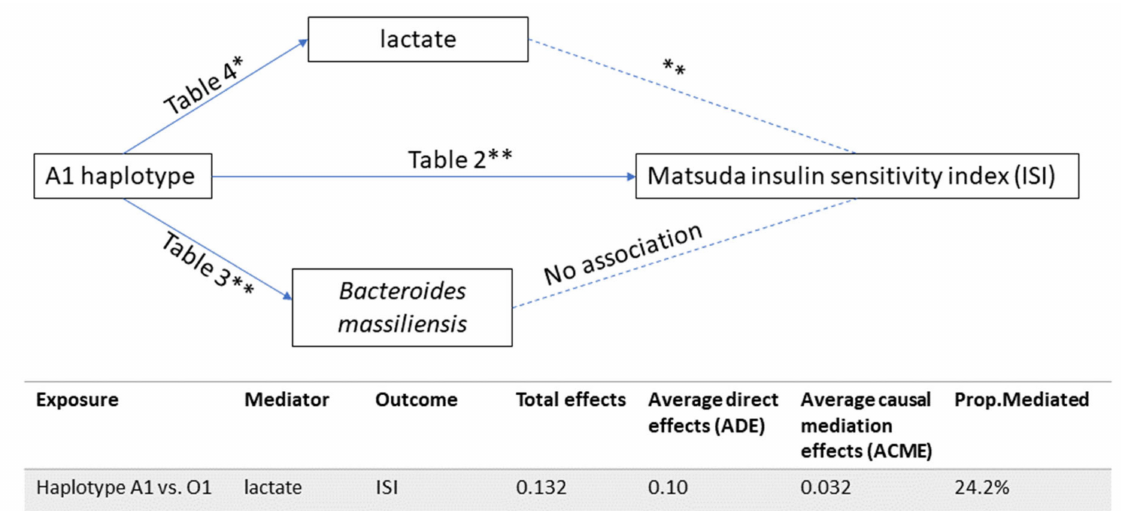
Figure 1. Mediation analysis between A1 haplotype and ISI. * marginally significant with a p -value < 0.05. ** Bonferroni corrected p -value < 0.004 (0.05/13) for bacterial species, and Bonferroni corrected p -value < 0.0024 (0.05/21) for